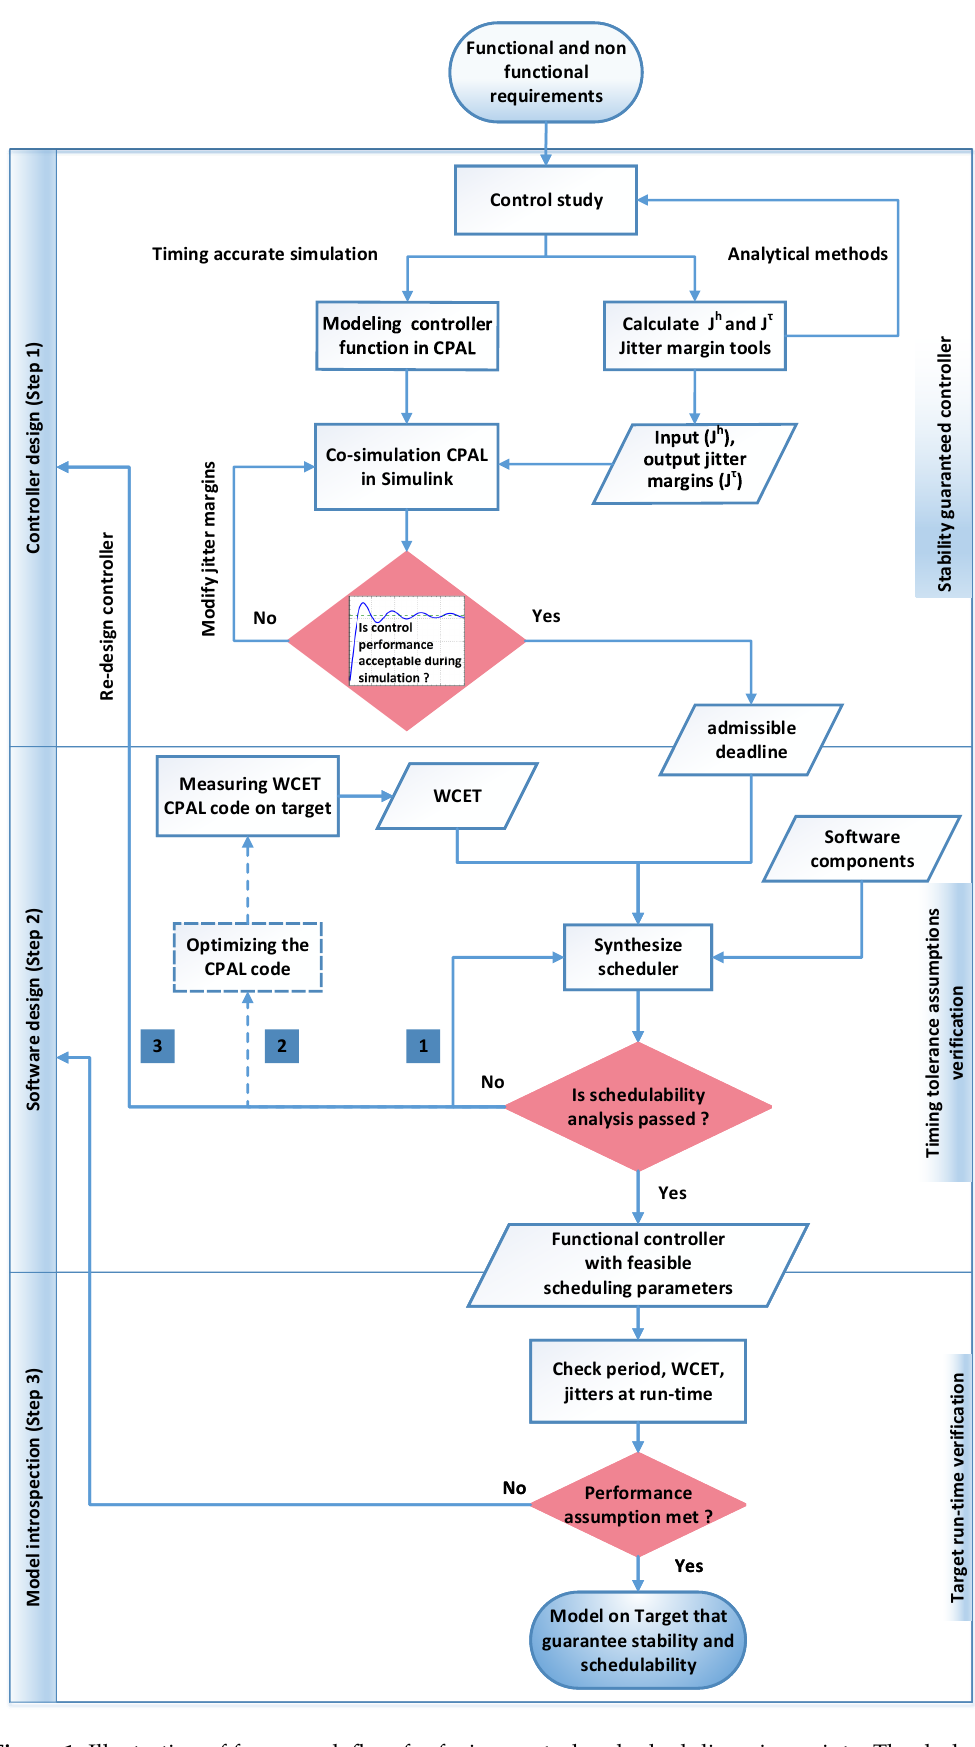
Figure 1. Illustration of framework flow for fusing control and scheduling viewpoints. The dashed part in the software design step is out-of-scope of this